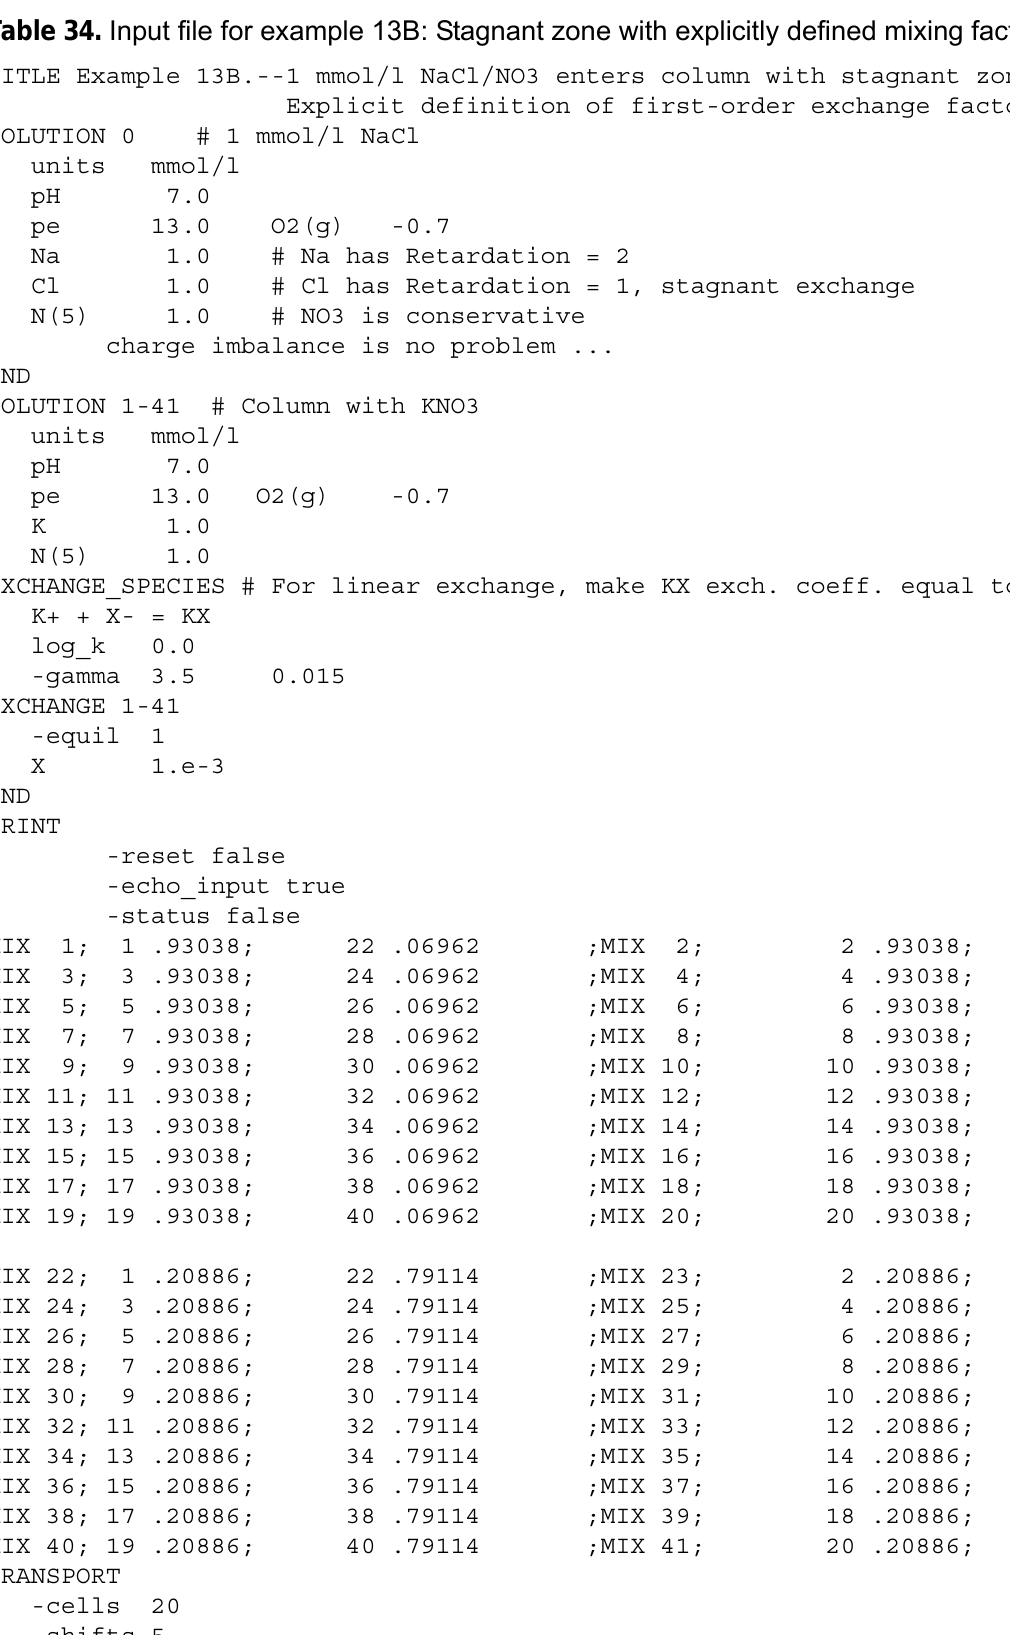
Table 34. Input file for example 13B: Stagnant zone with explicitly defined mixing factors. TITLE Example 13B.--1 mmol/l NaCl/NO3 enters column with stagnant zones. Explicit definition of first-order exchange